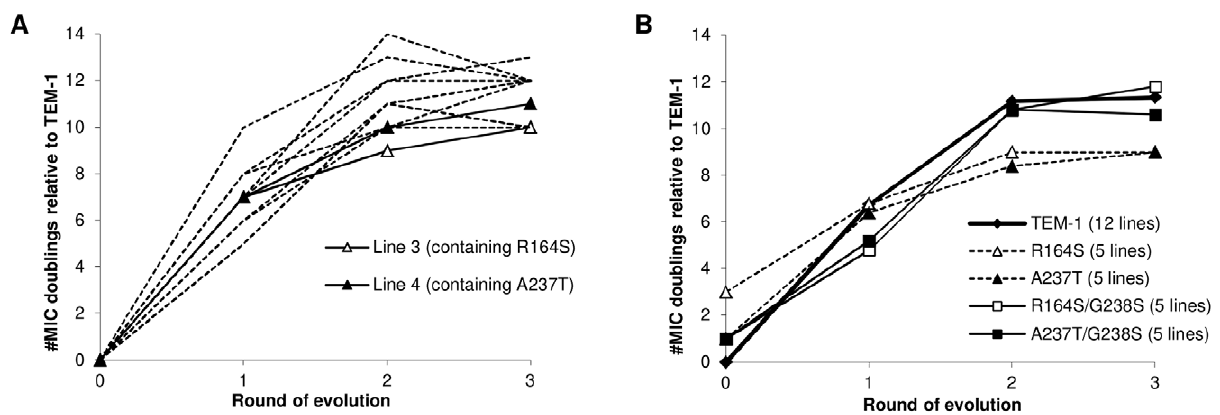
Figure 1. Cefotaxime MIC of selected TEM alleles. (A) Adaptation of TEM-1 b -lactamase towards improved hydrolysis of cefotaxime. Lines show changes in the average Minimal Inhibitory Concentration (MIC) of cefotaxime for the twelve lines shown in Figure 2 (see Table S3 for replicate MIC values). Aberrant lines 3 and 4 are indicated with solid lines and open and closed triangles, respectively. (B) Increase in cefotaxime MIC for TEM-1 (bold line, the average of Figure 1A) and mutants R164S (open diamonds, dashed line), A237T (diamonds, dashed line), R164S/G238S (open squares) and A237T/G238S (squares).